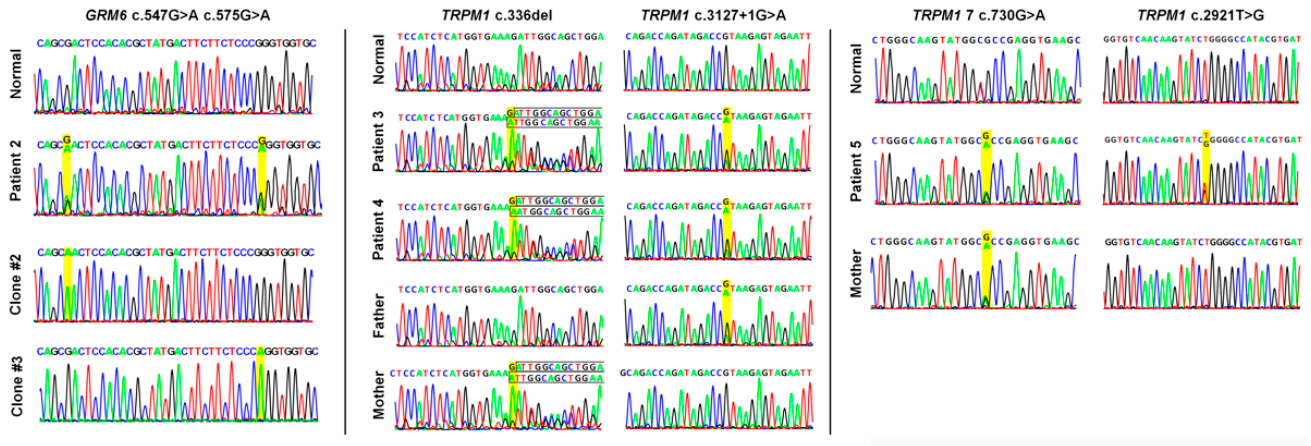
Figure 5. Phase determination for compound heterozygous patients